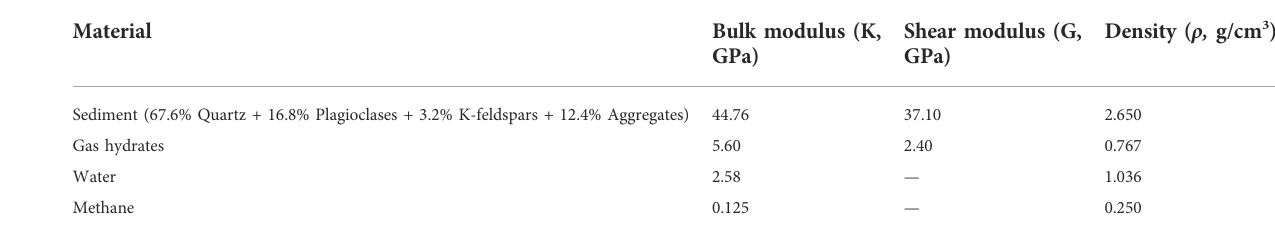
where F i is the volume ratio of each mineral consisting of the solid phase and K i and G i are the bulk and shear moduli of each mineral, respectively. Substring i means the index of each mineral, and m is the total number of minerals. K f is the bulk modulus of the fl uid phase, which means the pore- fi lled material. In water- fi lled sediments, K f is the same as K w (bulk modulus of water).